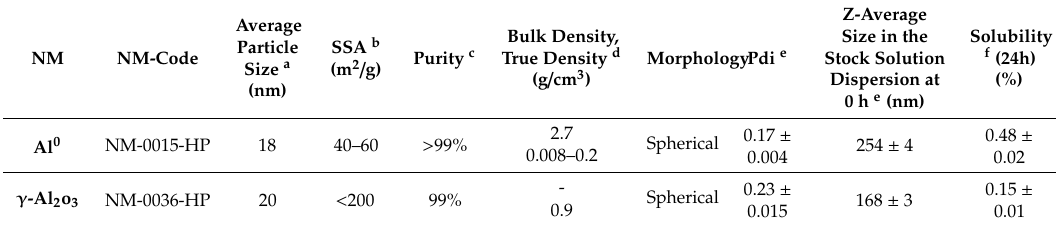
Table 1. Summary of nanomaterial (NM)